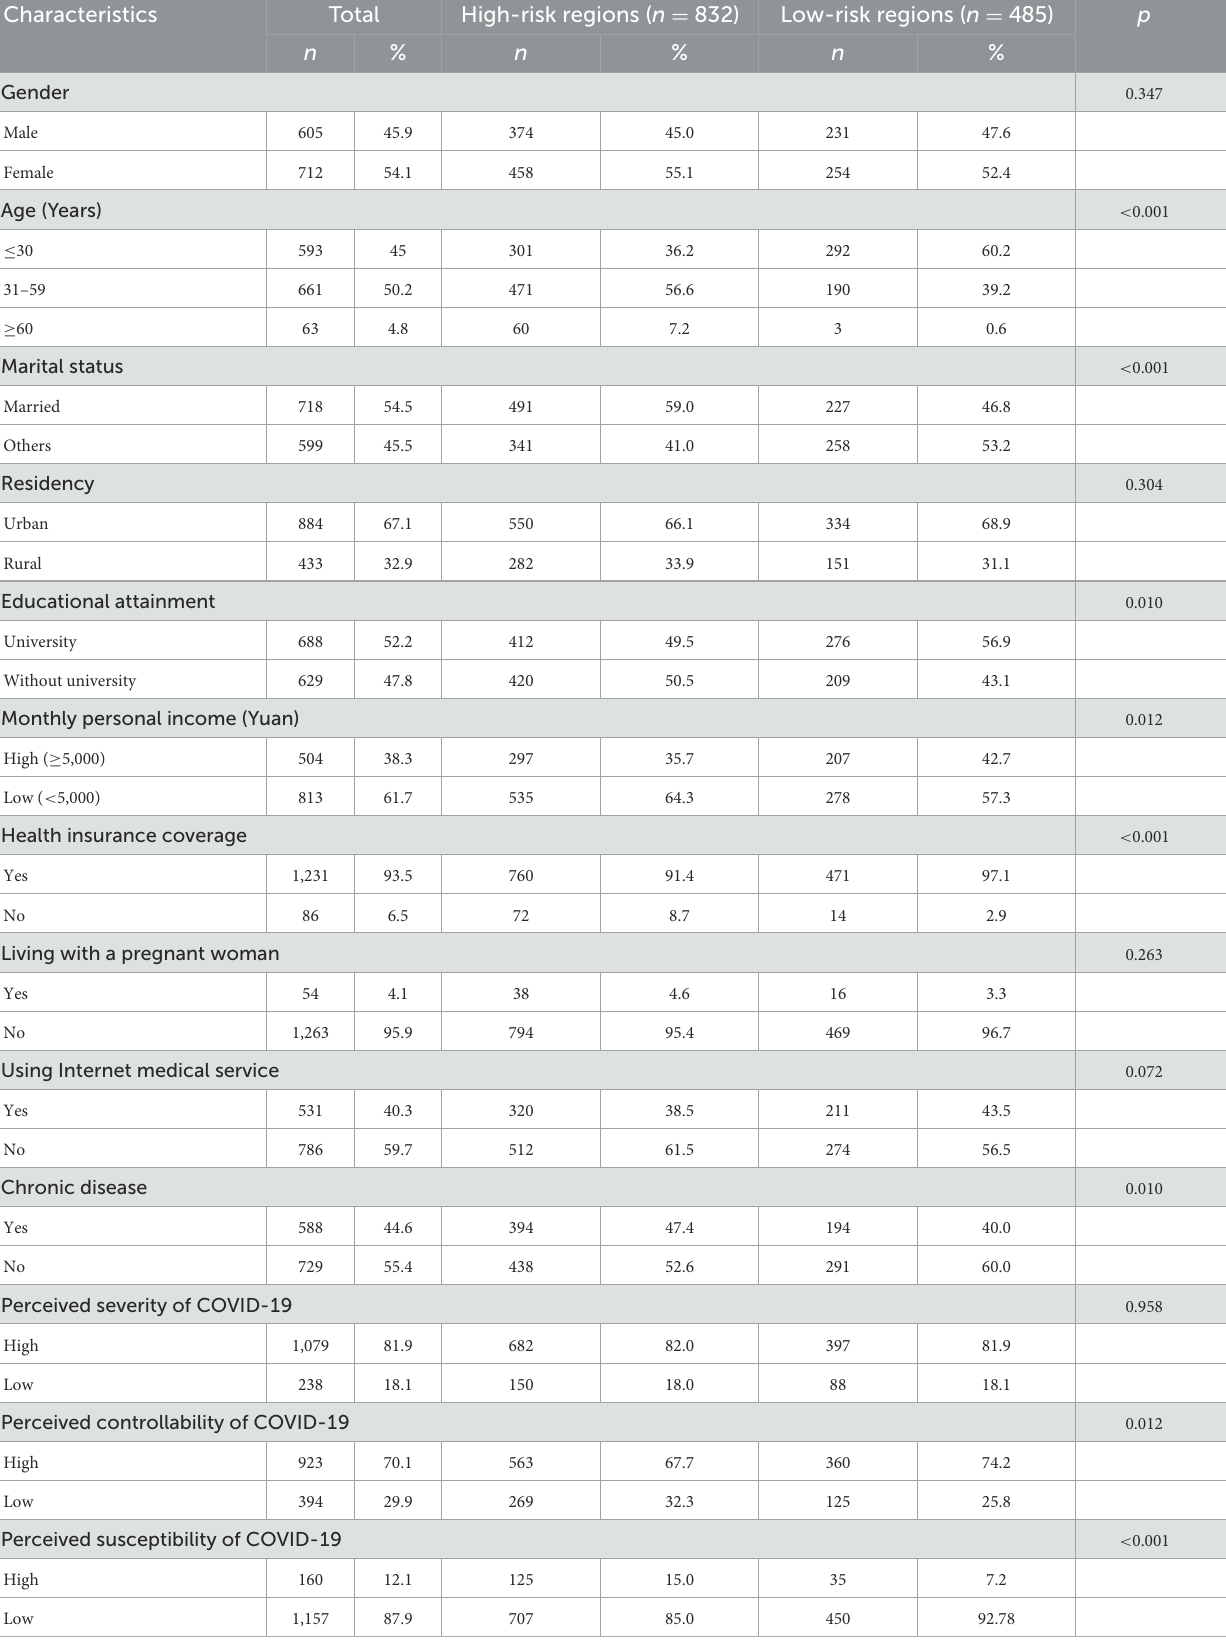
TABLE 1 Characteristics of study participants reporting a need to seek health care ( n = 1,317).